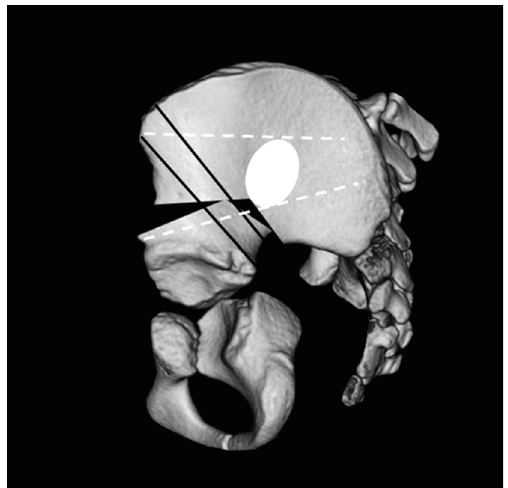
Figure 6: White dot lines indicate the Kirschner wire inserted after the pelvic fracture. We think wire insertion at this position can also prevent fracture like the current